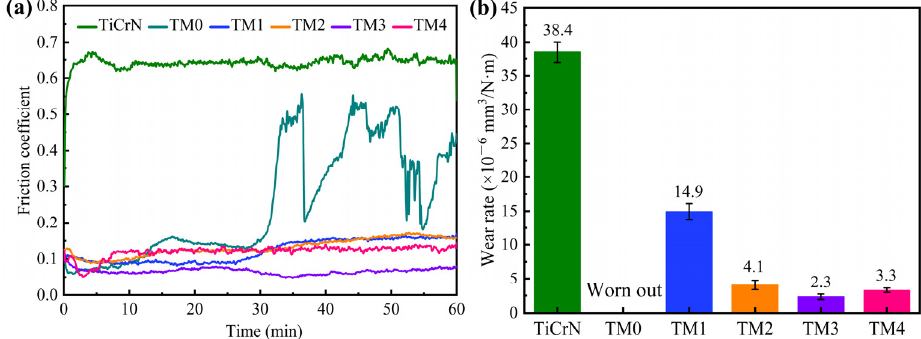
Figure 11. ( a ) Friction coefficient curves and ( b ) wear rates of the